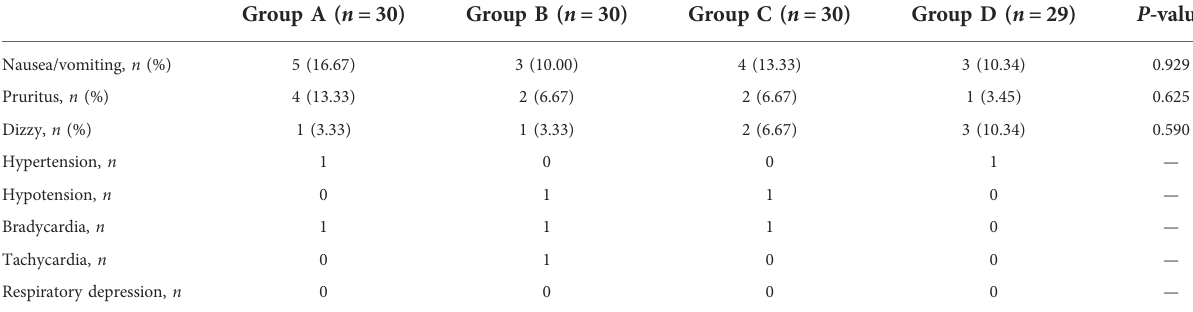
TABLE 4 Summary of adverse events in study